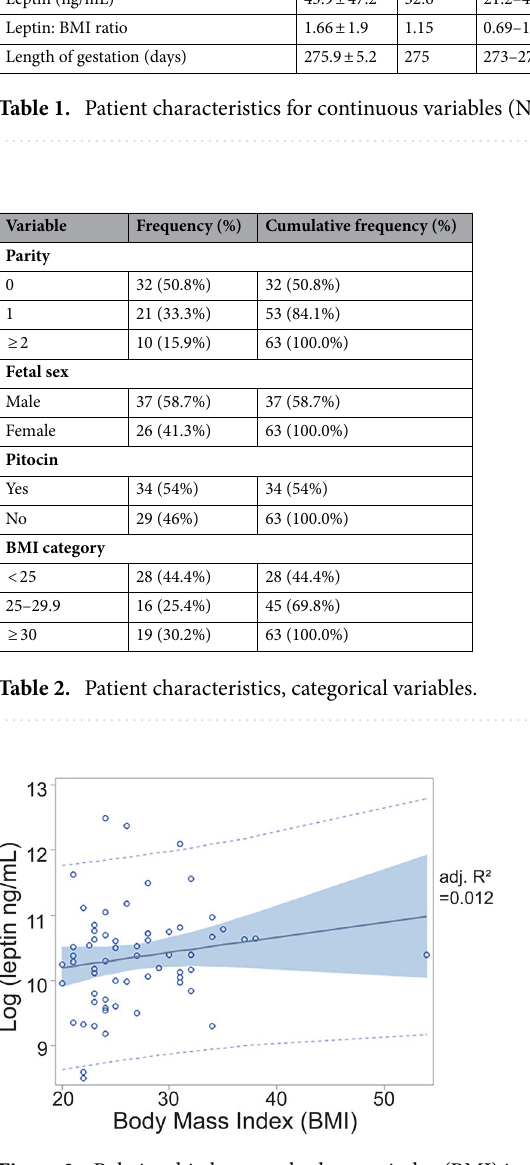
Figure 2. Relationship between body mass index (BMI) in the first trimester and mid-gestation serum leptin concentrations. Leptin concentrations are log-transformed to achieve a normal distribution. There is a weak relationship (β = 0.02, p = 0.18). Each circle represents a single observation, the solid line is the best fit line, and the shaded area indicates the 95% confidence